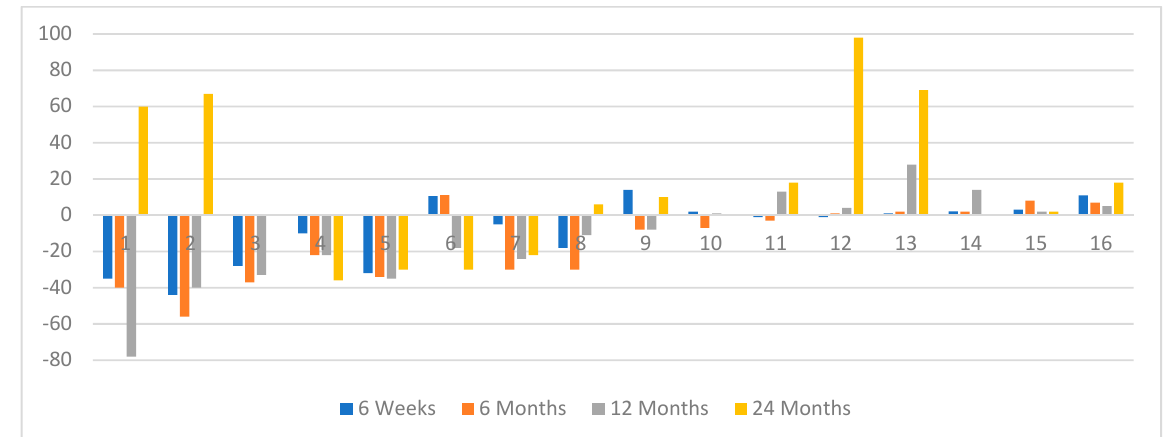
Figure 3. The waterfall plot of ORR in selected time frame points of evaluation at six weeks, six months, 12 months, and 24 months in the group with previous i.v. PRRT ( n = 16). The median PFS and median OS for all patients were 24.1 months (CI 16.7–30.9) and